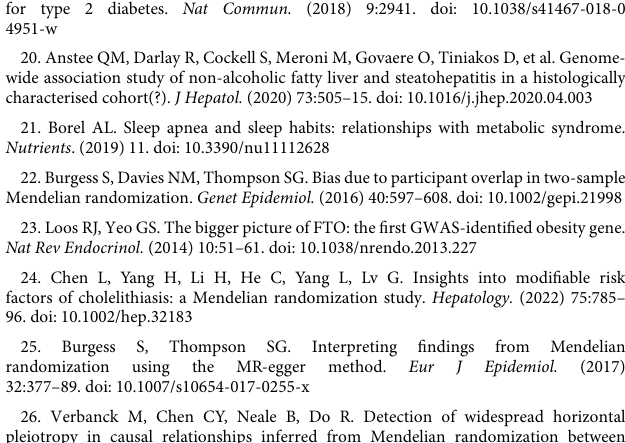
SUPPLEMENTARYFIGURE1 (A) The scatterplot of OSA-T2D results after removal of SNP rs9937053. Different colors represent different methods and each point is a single nucleotide polymorphism. The horizontal and vertical lines of each point represent the 95% confidence interval of the effect size. (B) The leave-one-out-sensitivity forest plot of OSA-T2D results after removal of SNP rs9937053. SUPPLEMENTARYFIGURE2 (A) The scatterplot of OSA-NAFLD results after removal of SNP rs9937053. Different colors represent different methods and each point is a single nucleotide polymorphism. The horizontal and vertical lines of each point represent the 95% confidence interval of the effect size. (B) The leave-one-out-sensitivity forest plot of OSA-NAFLD results after removal of SNP rs9937053. SUPPLEMENTARYFIGURE3 (A) The scatterplot of OSA-CHD results after removal of SNP rs9937053. Different colors represent different methods and each point is a single nucleotide polymorphism. The horizontal and vertical lines of each point represent the 95% confidence interval of the effect size. (B) The leave-one-out-sensitivity forest plot of OSA-CHD results after removal of SNP rs9937053.